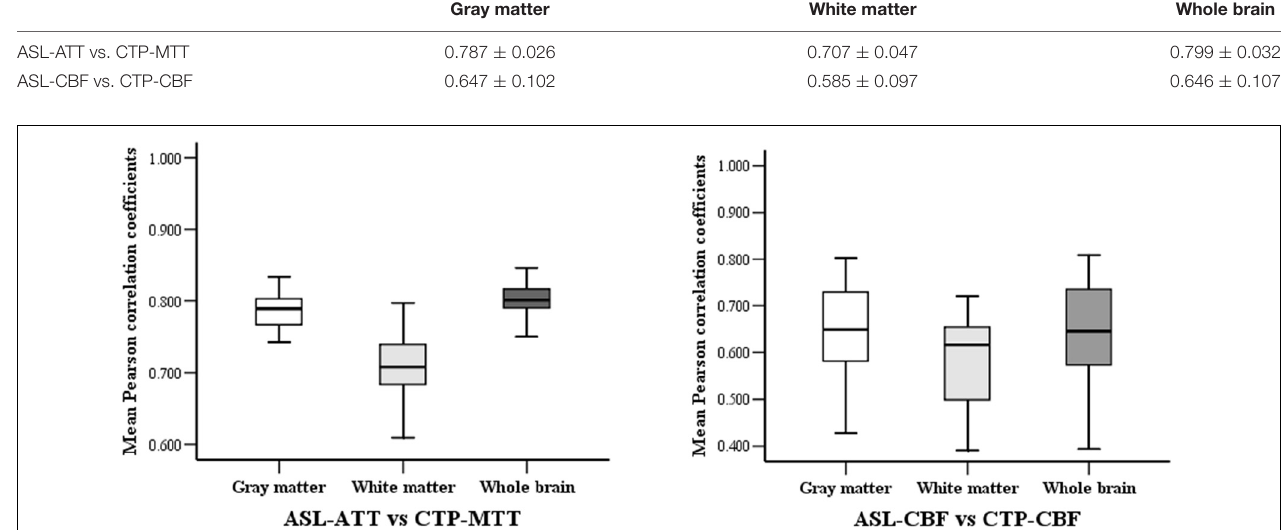
TABLE 3 | Mean Pearson correlation coefficients between the two modalities in gray, white matter and whole brain of 21 patients. Gray matter White matter Whole brain ASL-ATT vs. CTP-MTT ASL-CBF vs. CTP-CBF